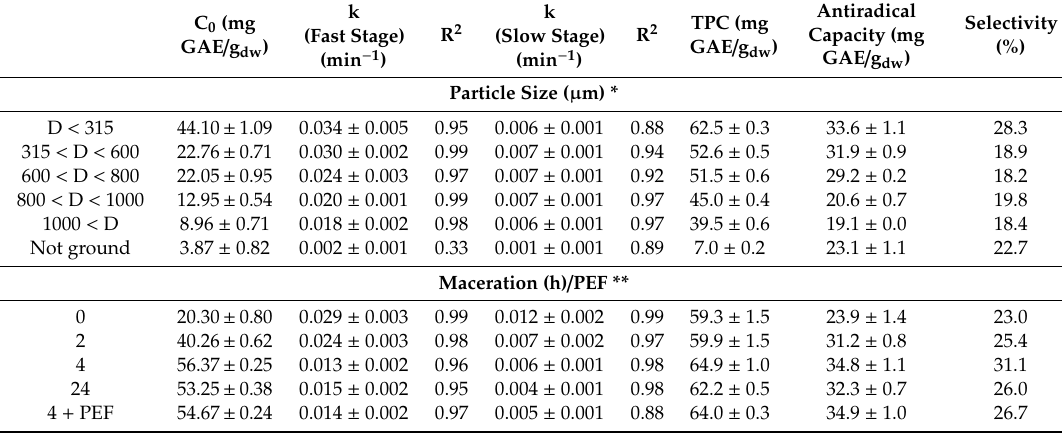
Table 4. The effect of grinding to different particle size, maceration at different duration, or maceration combined with Pulsed Electric Field (PEF) on the extraction model parameters, total phenolic content (TPC), antiradical capacity, and selectivity.